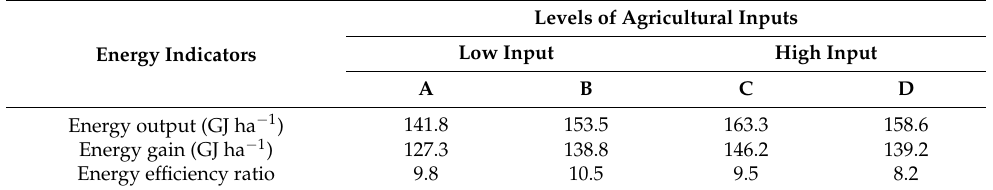
Table 6. Energy indicators in the production of a semi-dwarf genotype of winter triticale (2008–2011).